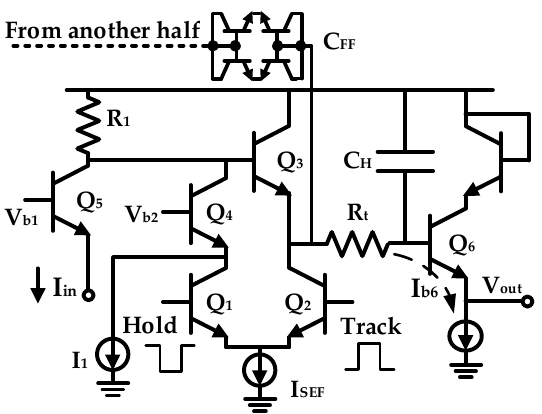
Figure 2. Half transistor-level schematic of the track-hold switch.